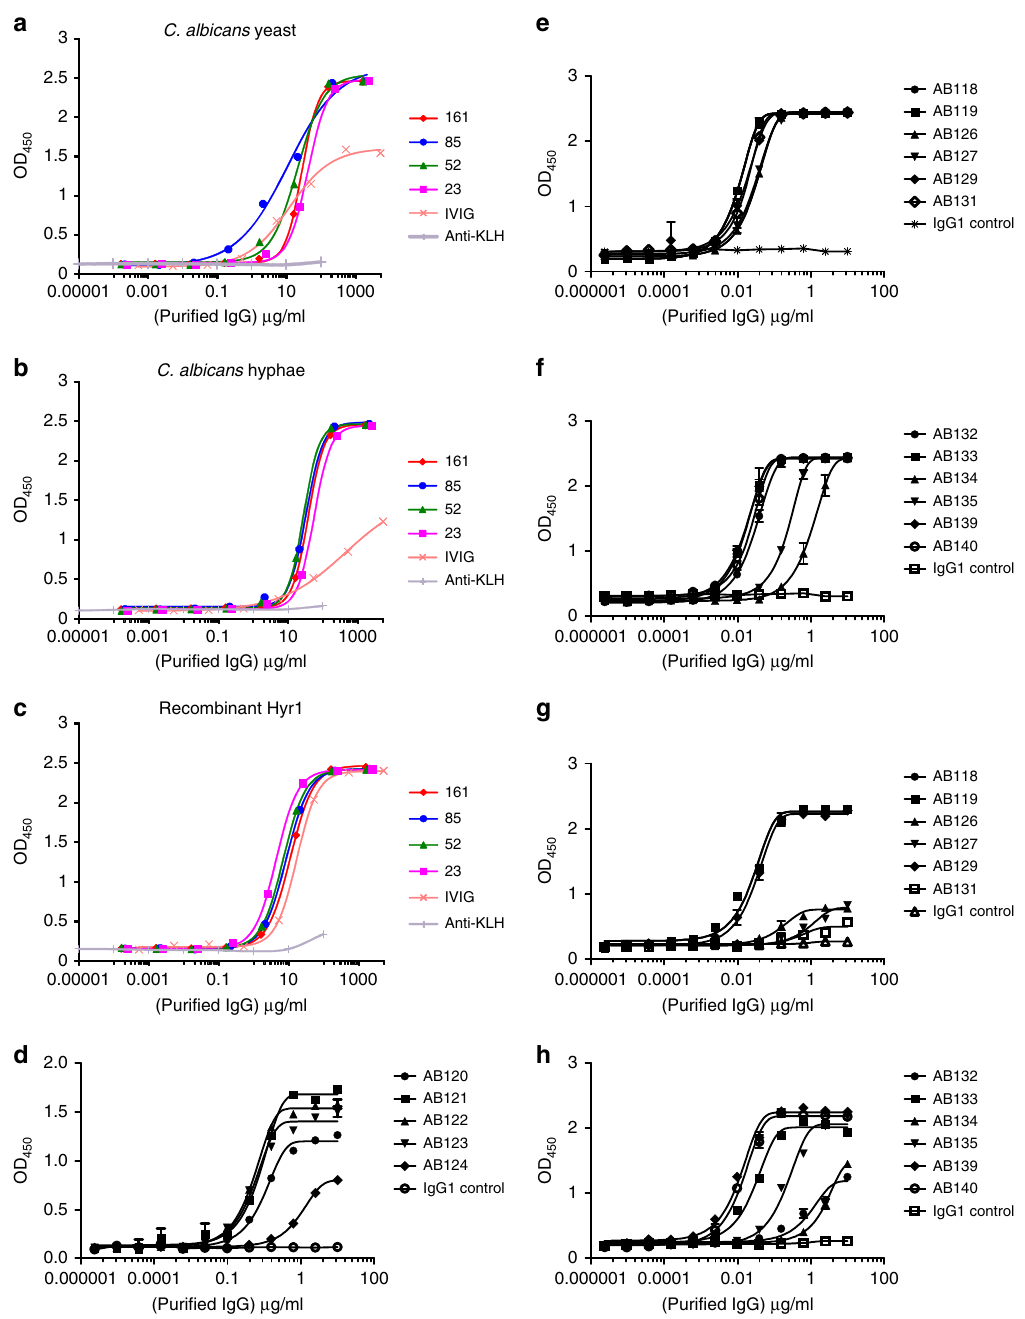
Fig. 2 Screen of donor circulating IgG and binding of puri fi ed anti-Candida mAbs to target antigens. Puri fi ed IgG isolated from donor serum was screened against C. albicans yeast cell wall extract ( a ), C. albicans hyphal cell wall extract ( b ), and recombinant Hyr1 protein fragment ( c ) via ELISA. Values represent means ( n = 2). d Puri fi ed anti-Hyr1 mAbs AB120-AB124 binding to puri fi ed recombinant Hyr1. e , g Puri fi ed cell wall mAbs AB118-AB131 binding to C. albicans yeast and hyphal cells respectively. Binding of the remaining cell wall mAbs AB132-AB140 to C. albicans yeast and hyphal cells via ELISA is shown in f and h respectively. Values represent mean ± SEM ( n = 2 – anti-whole cell mAbs to C. albicans , con fi rming that AB120 recognises a protein or proteoglycan epitope (Supplementary Figure 5c). Some anti-whole cell mAbs demonstrated increased fl uorescence after enzymatic treatment, suggesting that their epitopes might be located deeper in the cell wall.